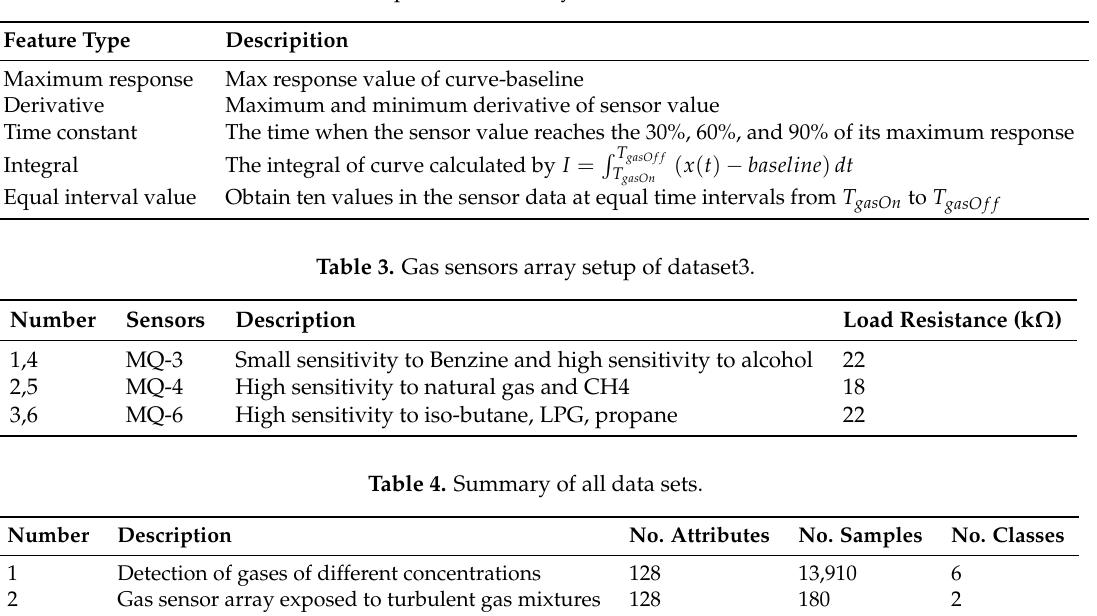
Table 2. Feature description for ordinary sensors in dataset2 and dataset3.